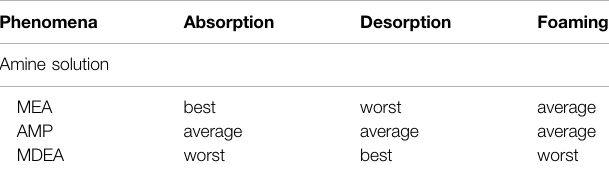
Figure 7 . Overall, the mathematical reactor model was good